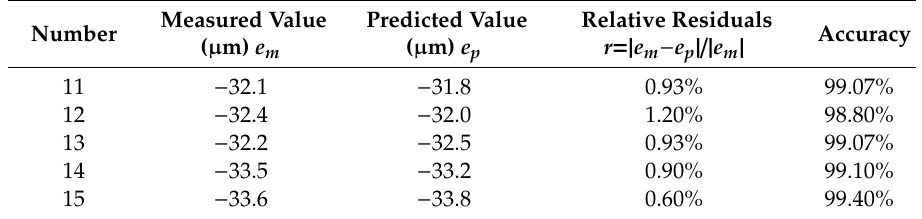
Table 5. Comparison between the predicted data of x 1 -axis positioning errors and the actual value.